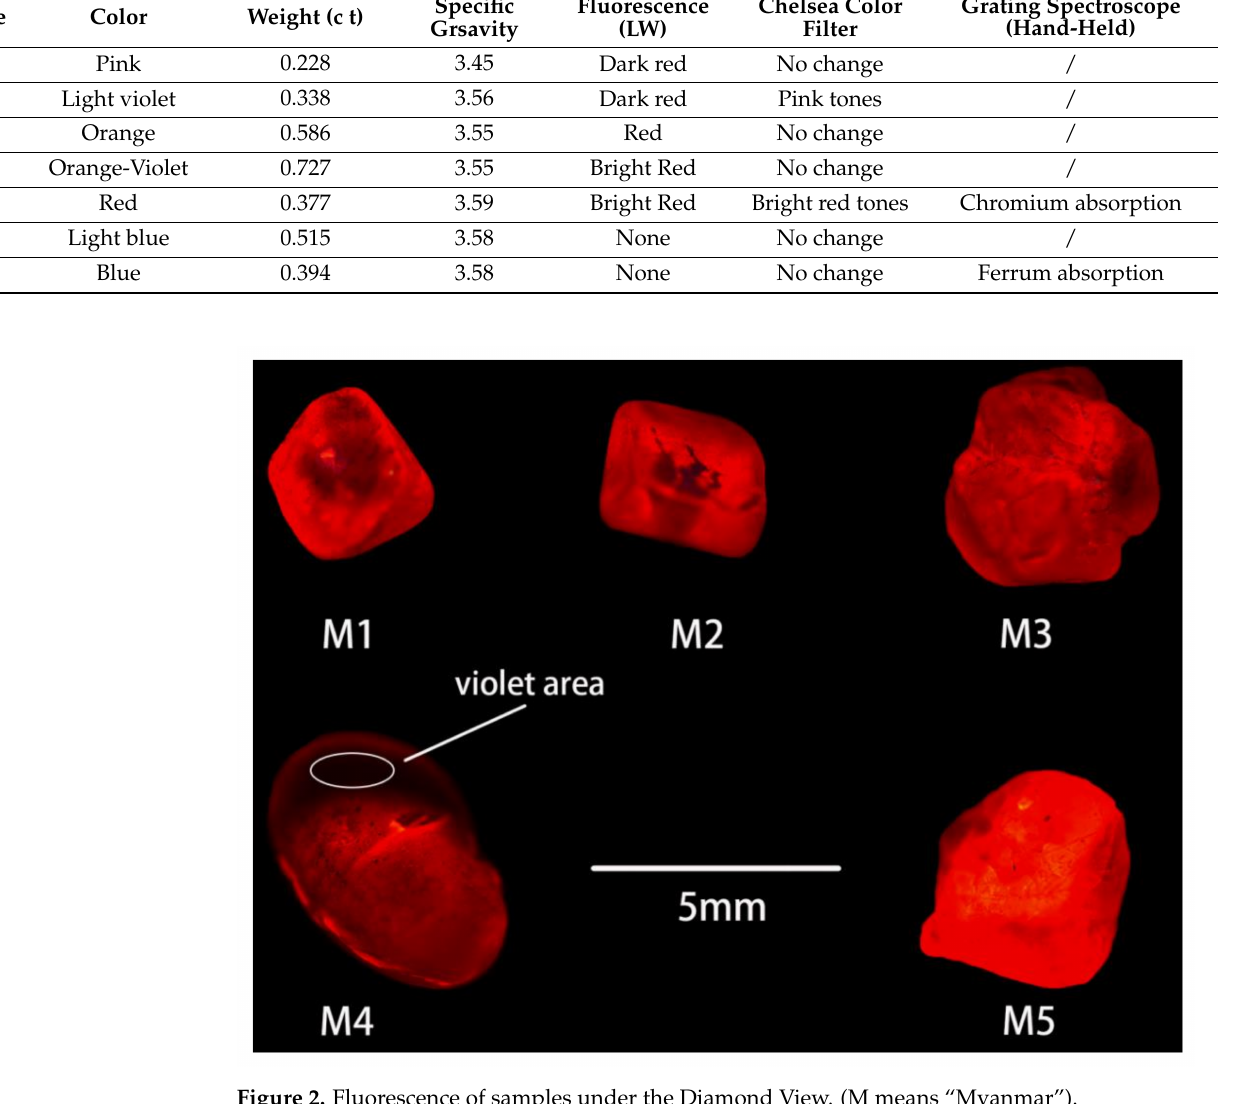
Figure 2. Fluorescence of samples under the Diamond View. (M means